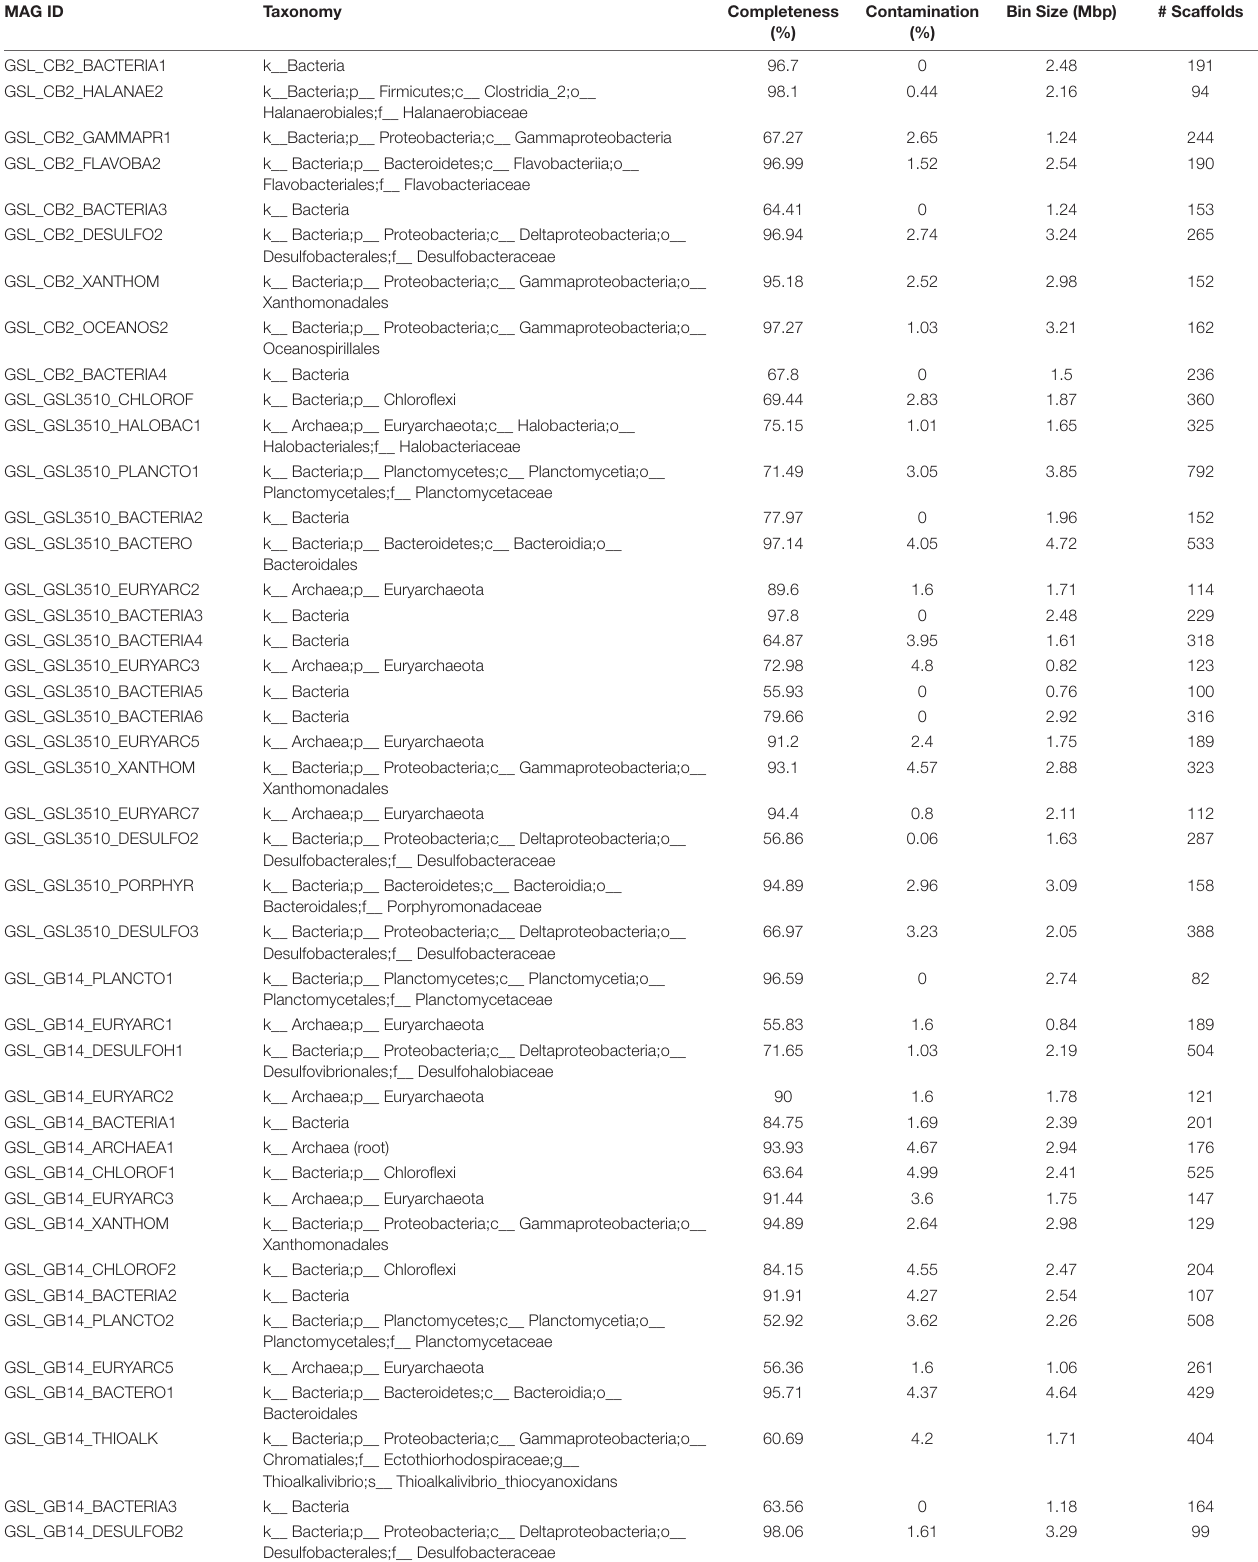
TABLE 2 | Genome statistics of MAGs from the Great Salt Lake (Utah, United States) selected for phylogenetic analysis (completeness ≥ 50%). MAG ID Taxonomy Completeness